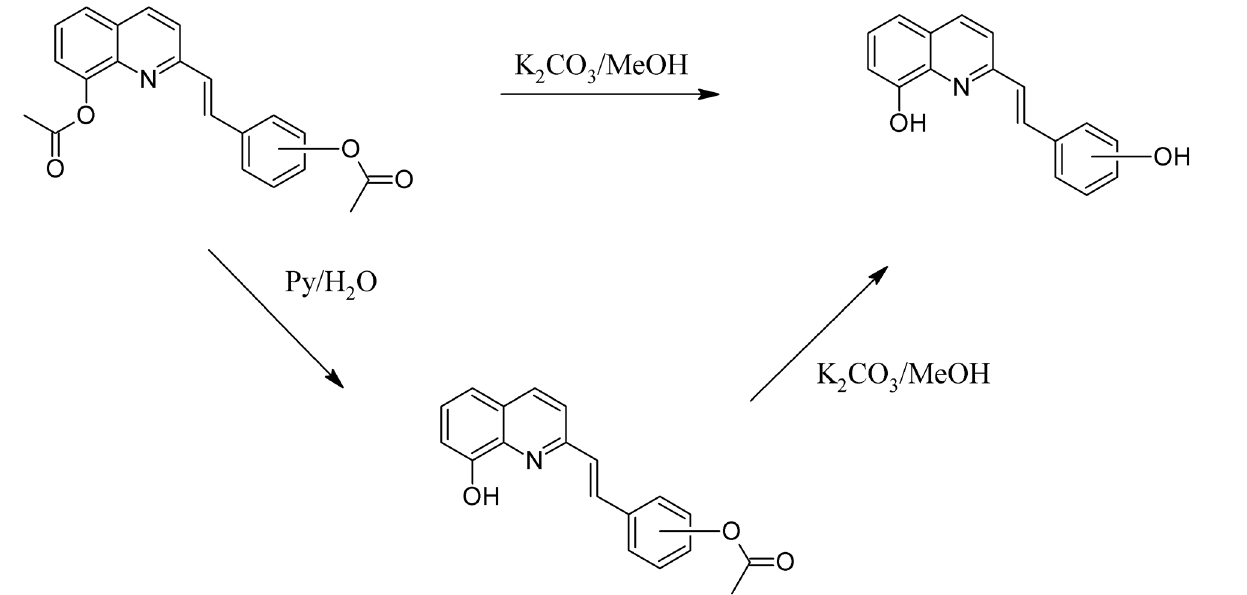
Fig 3. Selective hydrolysis of styrylquinolines. For example, compare 2b , 3b and 18b .